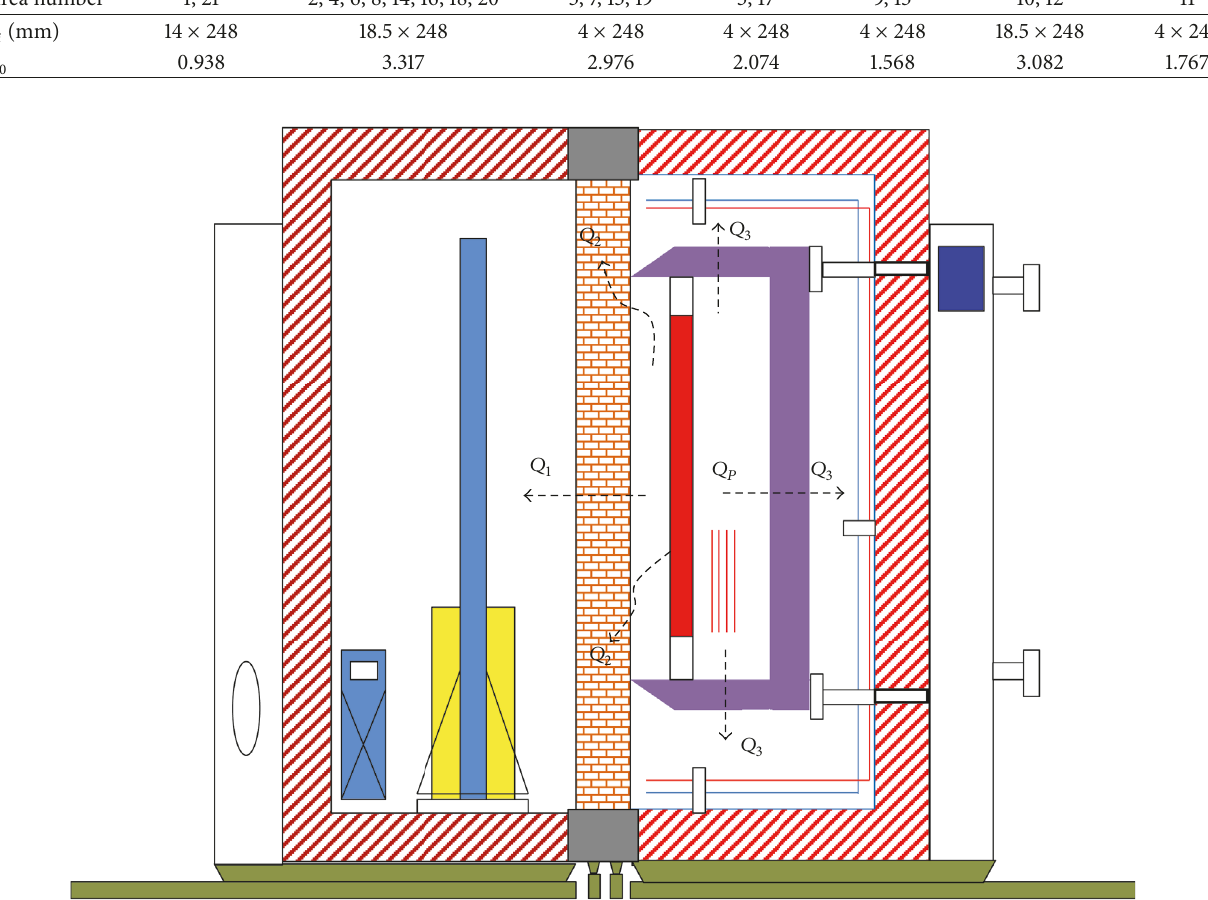
Figure 6: Illustration of the test